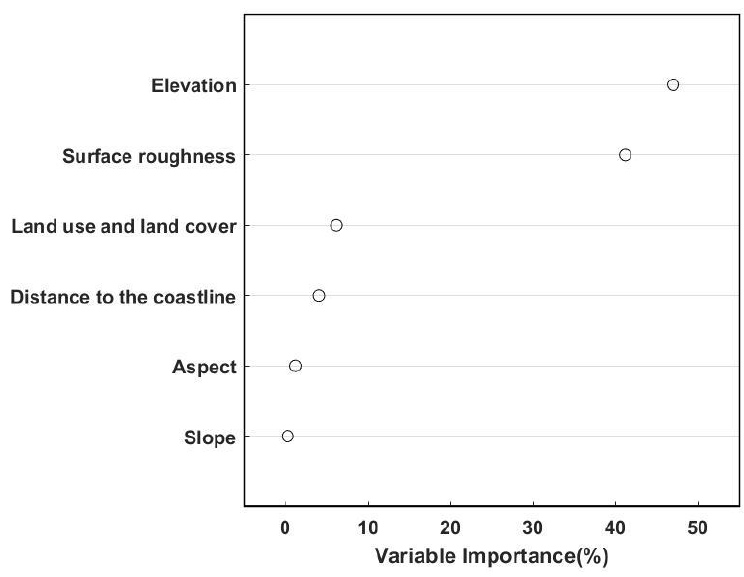
Figure 5. Variable importance plot.